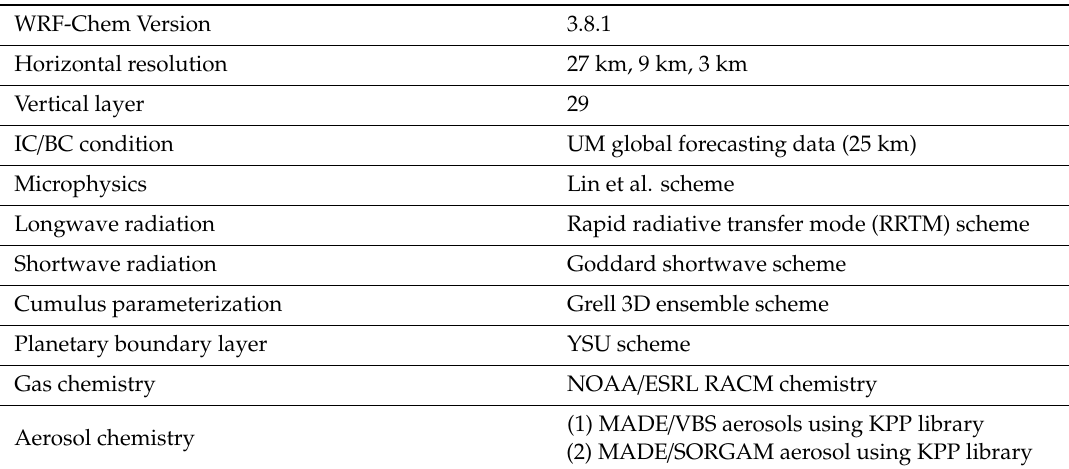
Table 1. Weather Research and Forecasting model coupled with Chemistry (WRF-Chem)